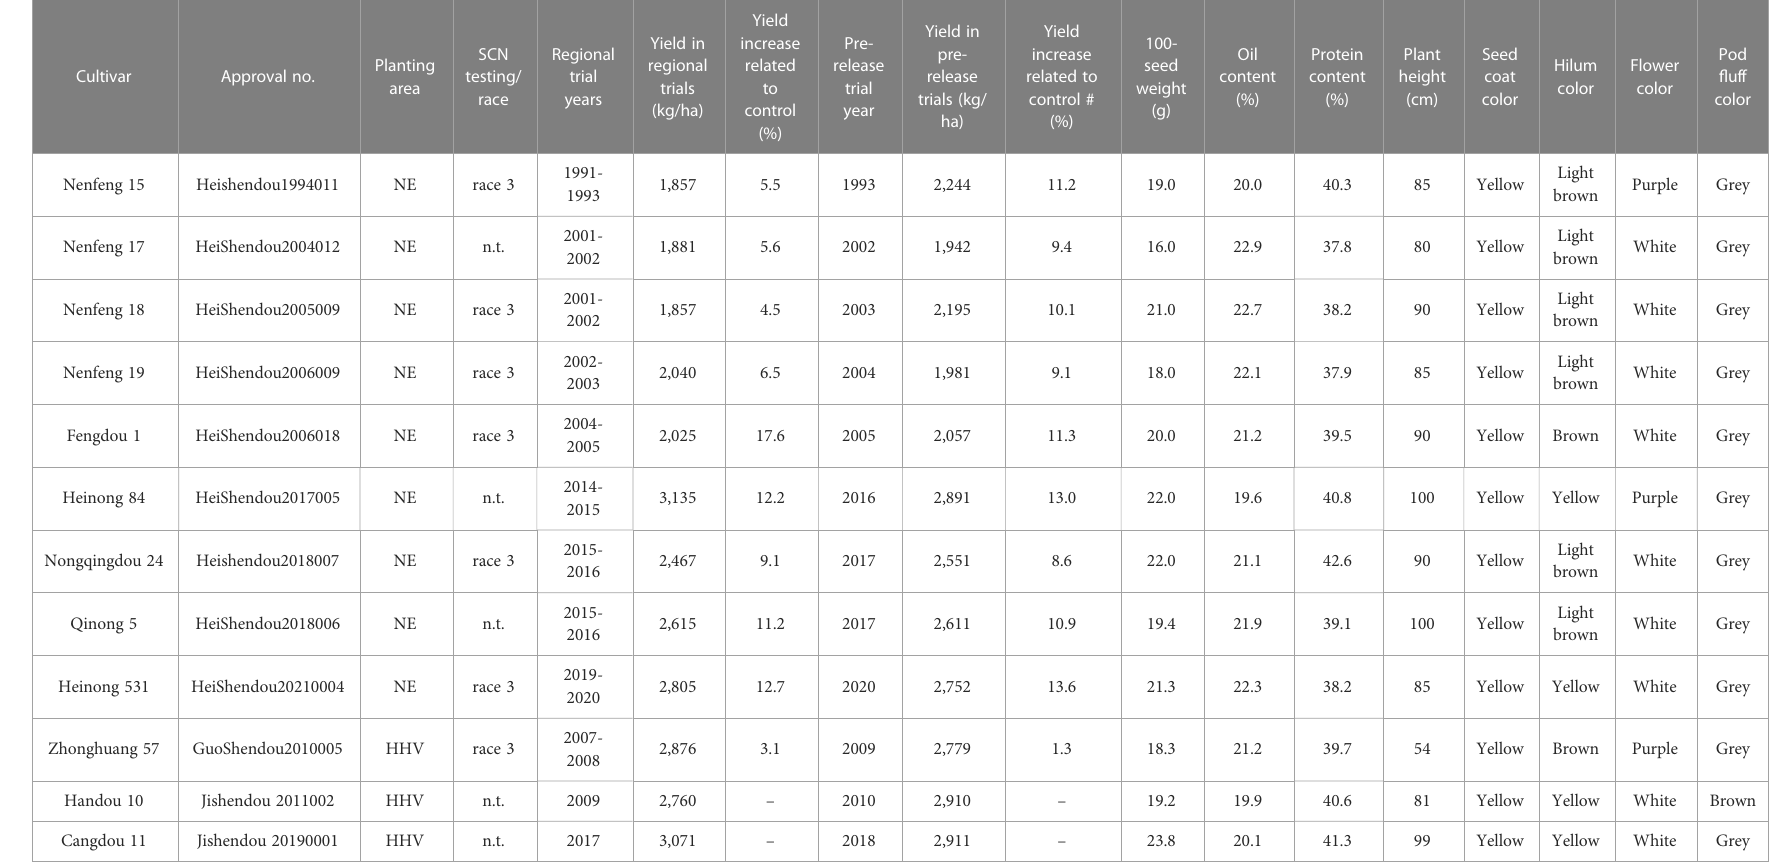
TABLE 1 Agronomic trait information according to the cultivar registration system, China.